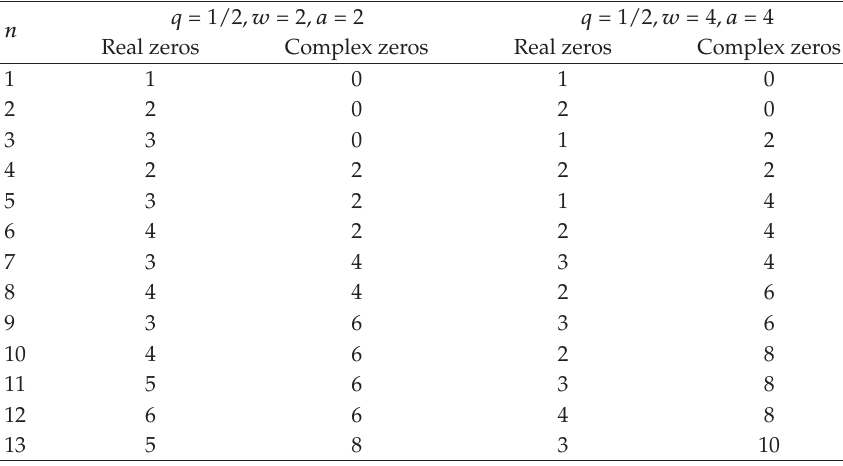
Table 1: Numbers of real and complex zeros of E n,q,w (cid:2) x : a (cid:3)